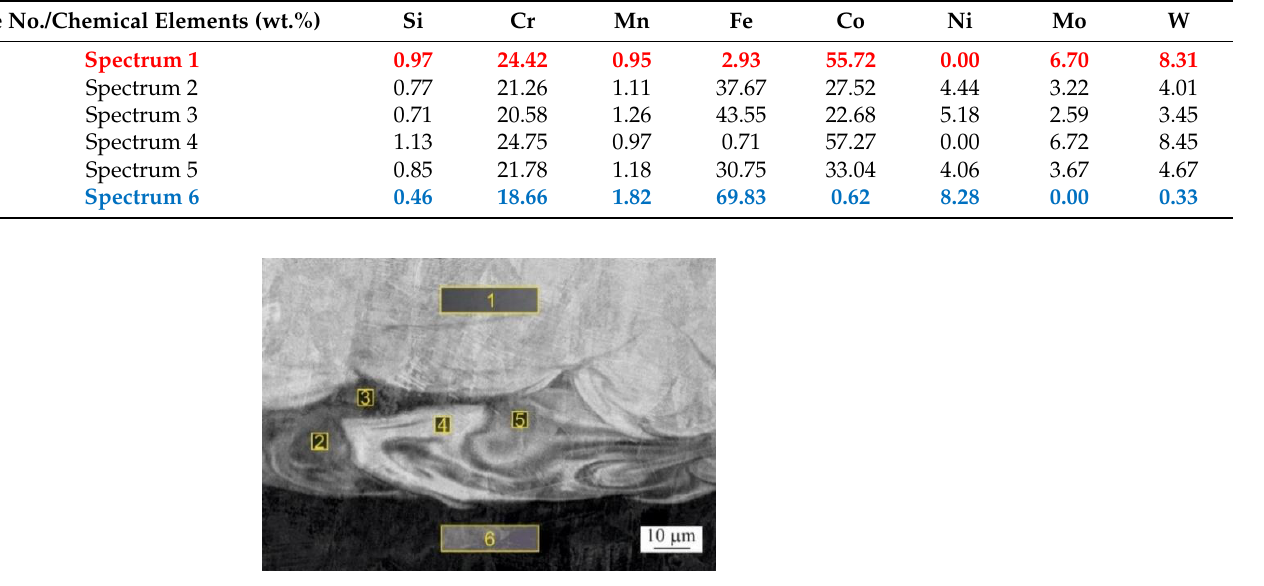
Figure 13. CoCr – 304 interface in SEM image used for EDAX point measurements detailed in Table Figure 13. CoCr–304 interface in SEM image used for EDAX point measurements detailed in Table 5. Table 5. EDAX point measurement data for sites indicated in Figure 13. Red color indicates CoCr alloy composition; blue color indicates 304 stainless steel composition. Site No./Chemical El- ements (wt.%)